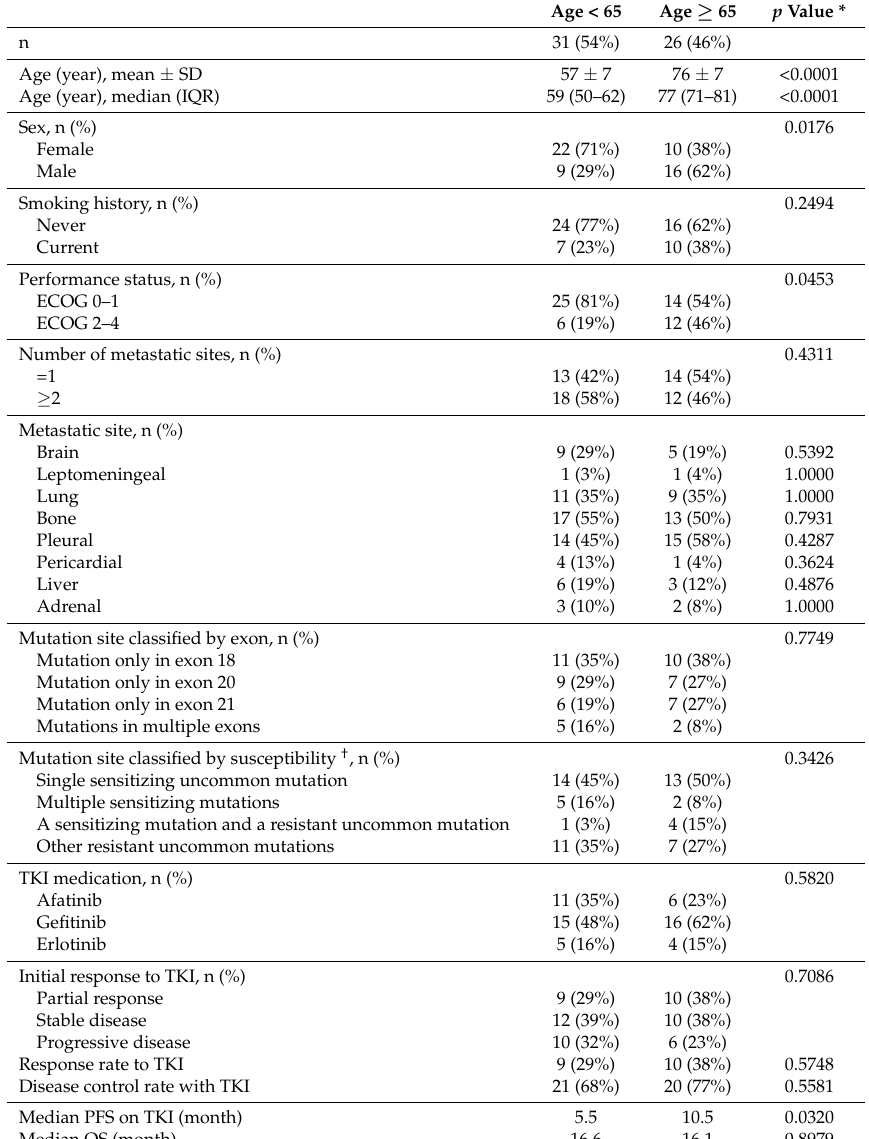
Table 5. Characteristics of the patients with stage IV lung cancer harboring uncommon mutation receiving a first-line tyrosine kinase inhibitor (TKI), classified by the age